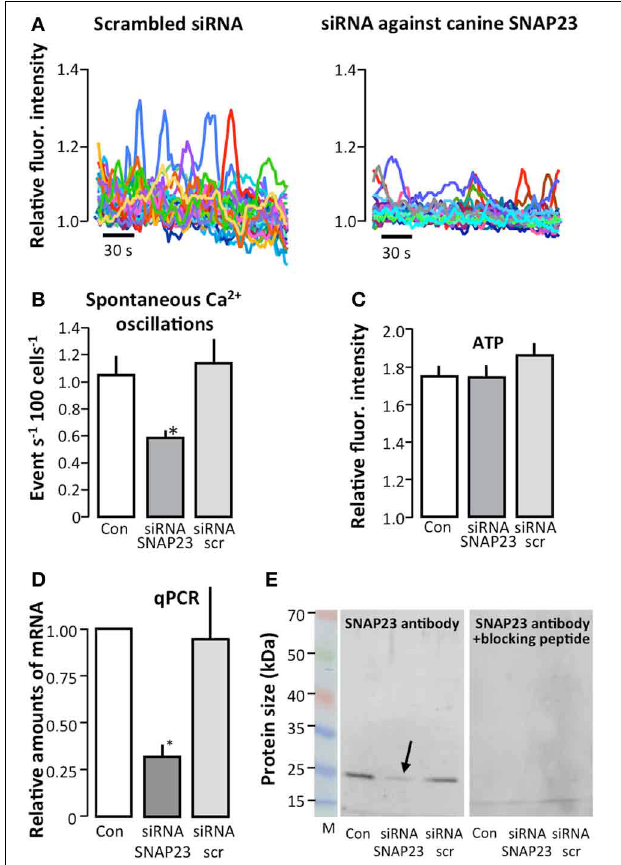
FIGURE 5 | Effect of siRNA-mediated knockdown of canine SNAP-23 in MDCK cells. The effect of transfection of MDCK cells with